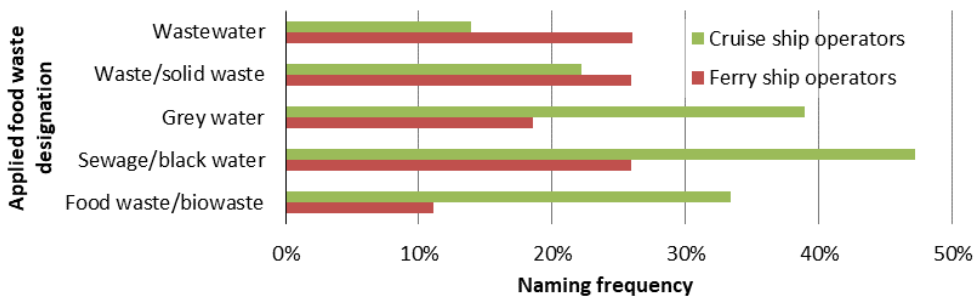
Figure 3. The frequencies of different synonyms applied to food waste and greywater found using search engines (Google, Yandex, etc.) in descriptive sections of cruise and ferry ship operators’ webpages dealing with the management of such